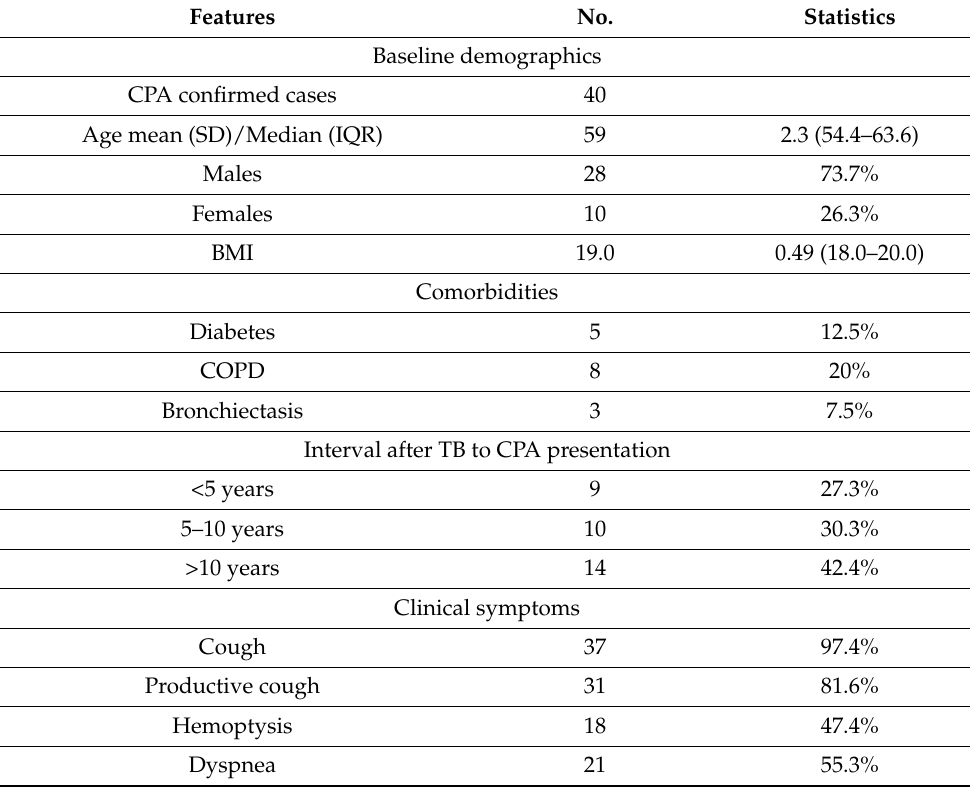
Table 1. The demographic, clinical symptoms, and radiological findings of CPA